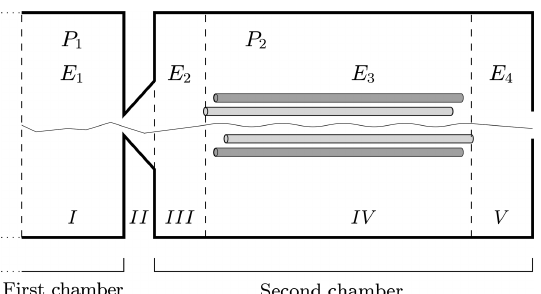
Figure 4. Simulated region of APi-TOF mass spectrometer. The dashed lines identify the regions with different voltages. The thin solid line illustrates a single realization of a cluster trajectory. The regions’ lengths are not to scale.